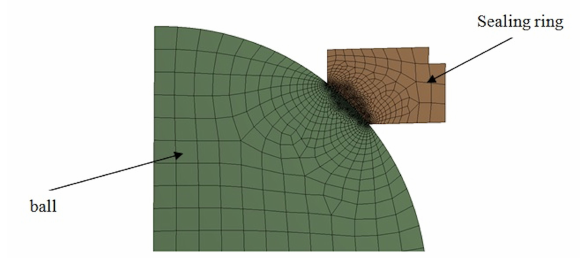
Figure 3: Computational mesh of the model